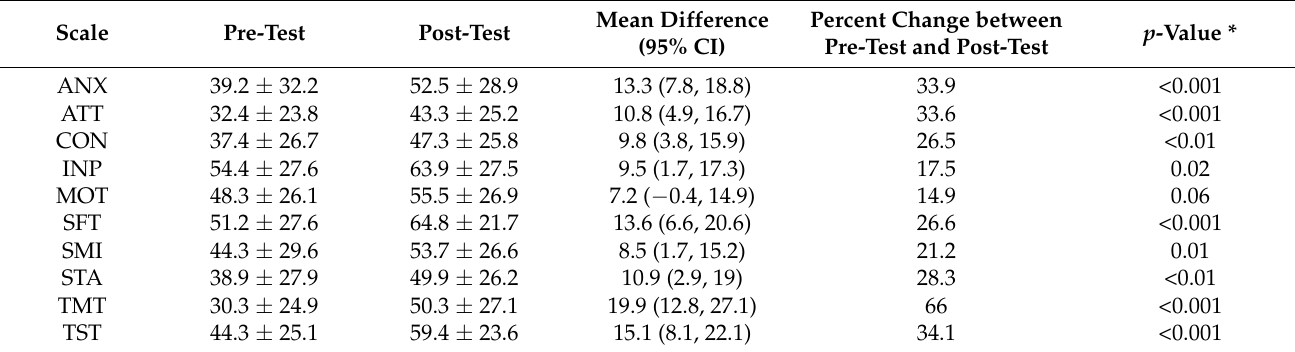
Table 3. Mean and SD of pre- and post-LASSI ten scales (n =